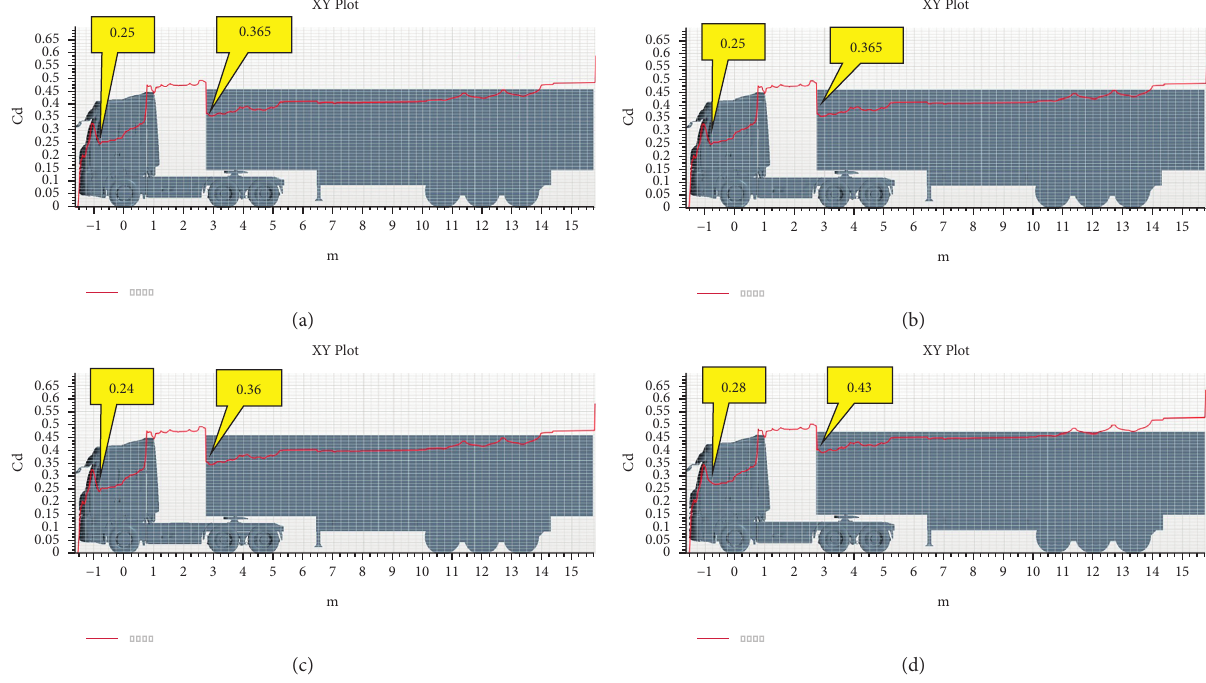
Figure 4: Wind drag development curve of four status commercial vehicles. (a) OSRVM A. (b) OSRVM B. (c) OSRVM C. (d) NO OSRVM.